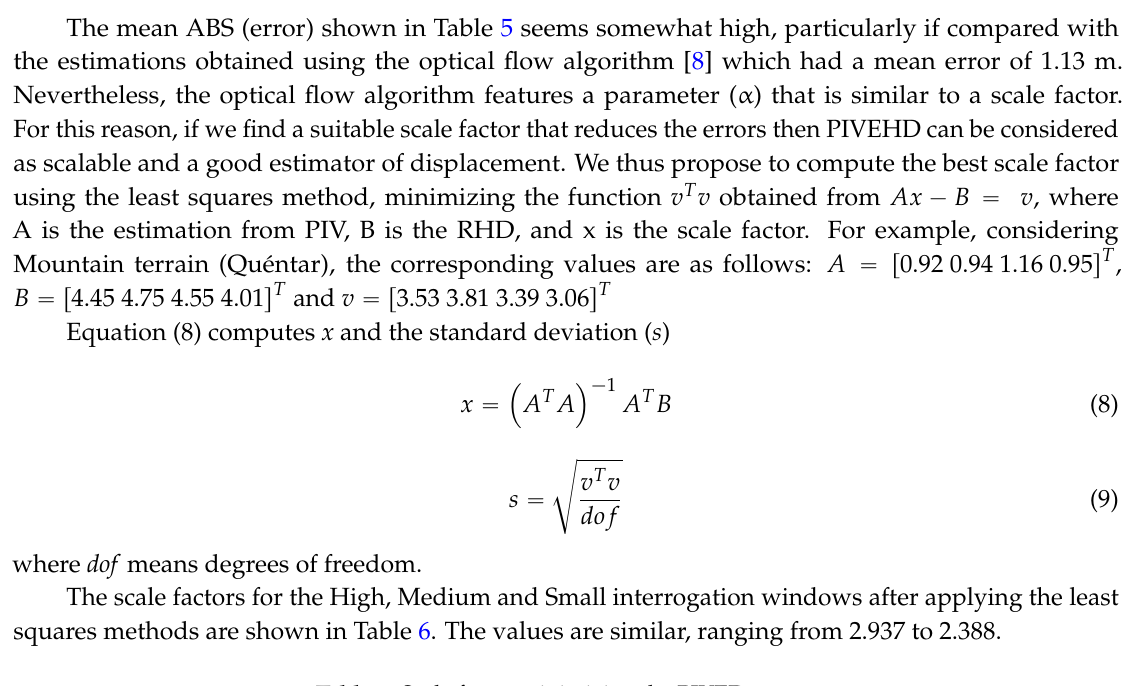
Table 6. Scale factor minimizing the PIVED errors. Interrogation Window